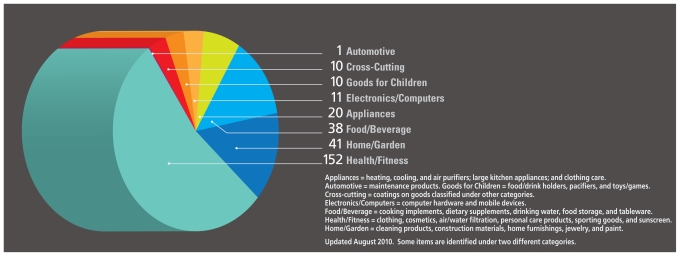
Numbers of Goods Containing Silver Nanoparticles4